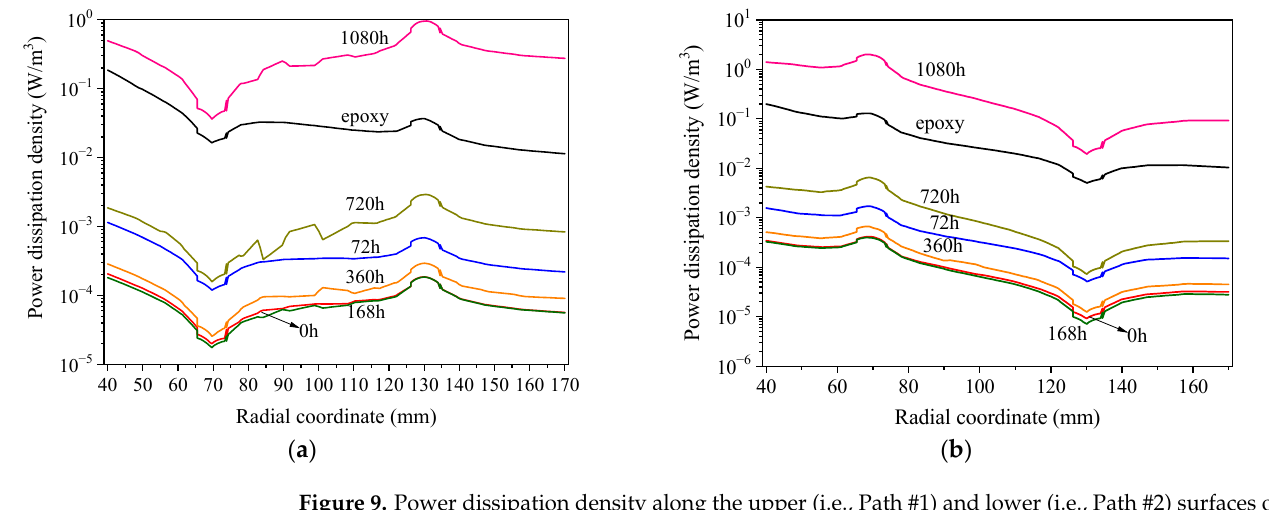
Figure 9. Power dissipation density along the upper (i.e., Path #1) and lower (i.e., Path #2) surfaces of pure epoxy and aged SiC/epoxy micro-composite spacer: ( a ) Upper surface; ( b ) Lower surface.